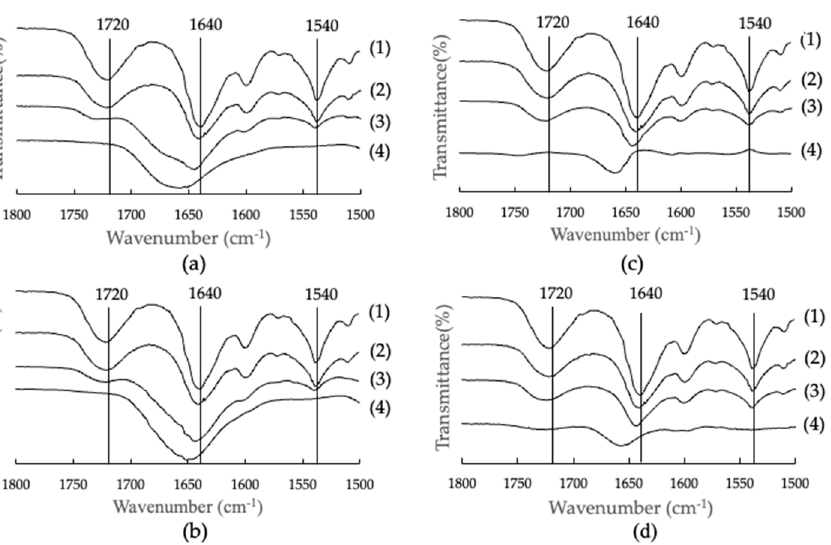
Figure 3. FTIR spectra from 1600 to 1700 cm − 1 of the various samples. ( a ) RB-T30 + PVPK-30, ( b ) RB- ( b ) RB-T180 + PVPK-30, ( c ) RB-T30 + HPC-L, and ( d ) RB-T180 + HPC-L. (1) RB crystals, (2) RB-T, T180 + PVPK-30, ( c ) RB-T30 + HPC-L, and ( d ) RB-T180 + HPC-L. (1)RB crystals, (2)RB-T, (3)PM, (3) PM, (4) (4)GM.